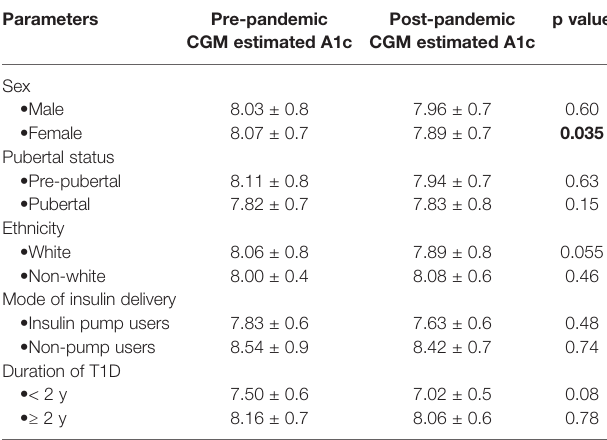
TABLE 4 | Change in the CGM-estimated HbA1c between the pre- and post- pandemic periods among the CGM users only